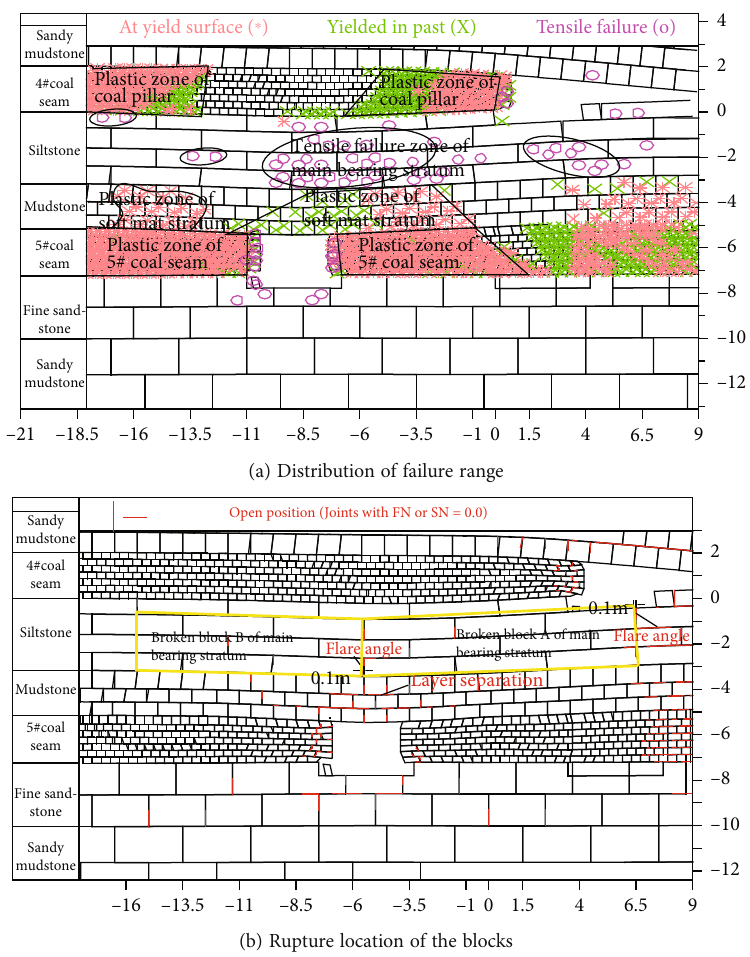
Figure 11: Failure of roadway surrounding rock under coal